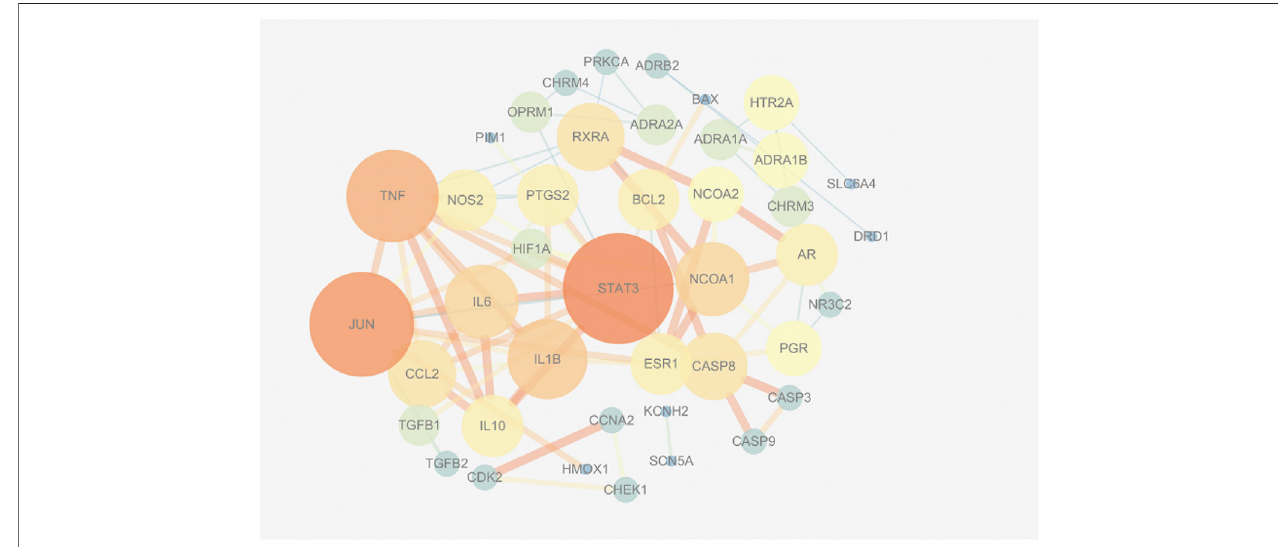
FIGURE 2 | The protein-protein interaction (PPI) network.